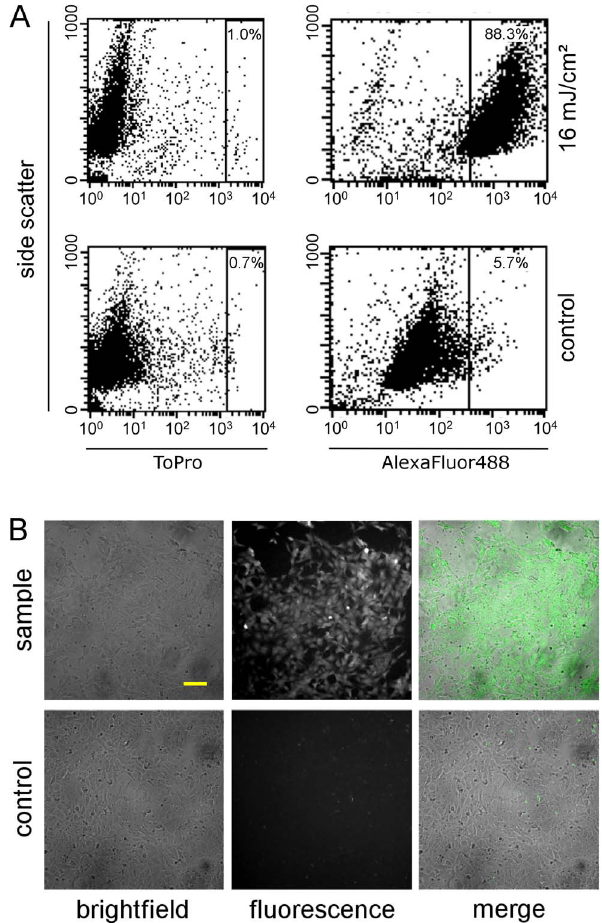
Figure 6. siRNA injection using GNOME laser transfection. A: Transfection of AlexaFluor488 labeled siRNA into ZMTH3 cells. 88% of the cells stained positive for the siRNA after transfection with the optimized parameters (0.5 m g/cm 2 AuNP, 20 mJ/cm 2 , 50 mm/s). B: Exemplary images of ZMTH3 cells transfected with AlexaFlour488-siRNA and control cells. Scale bar: 100 m m.